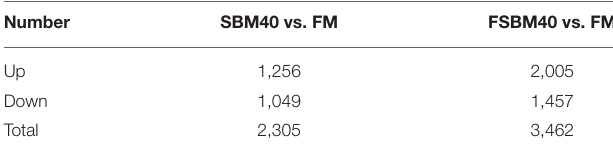
TABLE 9 | Comparison of significant differential genes between fermented soybean meal and soybean meal substitute for fish meal in hindgut of pearl gentian grouper ( n =